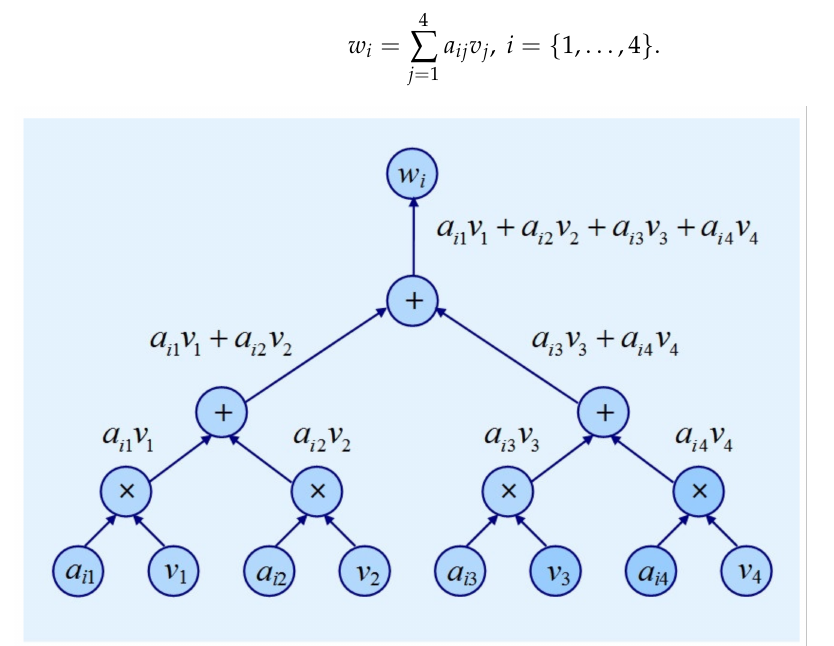
Figure 14. Graph of the computational process of a matrix (4 × 4) multiplication by a vector (4 ×